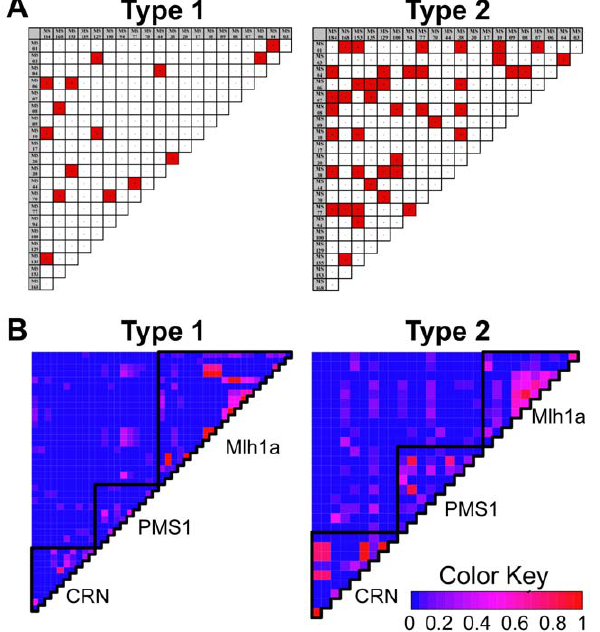
Figure 3. Linkage disequilibrium varies between type. (A) Pairwise linkage disequilibrium (LD) matrix for MS genotypes of type 1 (N=95) and 2 (N=93). Significant LD is highlighted in red. Type 2, with 42 cases of paired locus LD, shows a greater amount of LD in comparison to type 1 with 15 cases. (B) Heat maps indicating degree of LD between SNPs in single copy genes. Gene boundaries are indicated by black lines. The number of pairwise comparisons varies between the two types due to the difference in the number of polymorphisms analyzed, but a greater amount of pairwise LD in type 2 in comparison to type 1 is